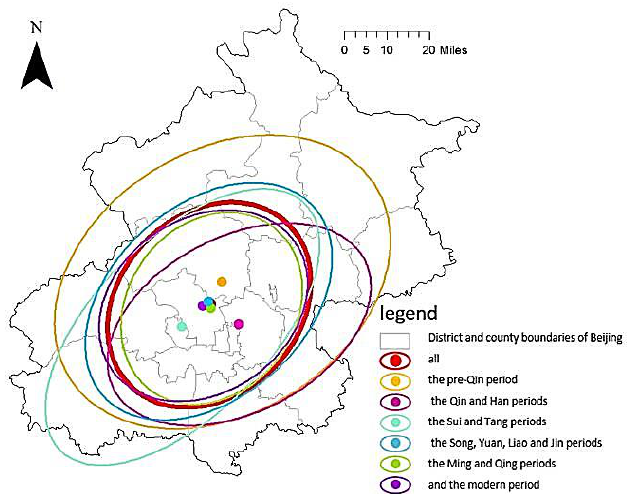
Figure 6. Oval distribution of standard deviations of cultural preservation units in Beijing.